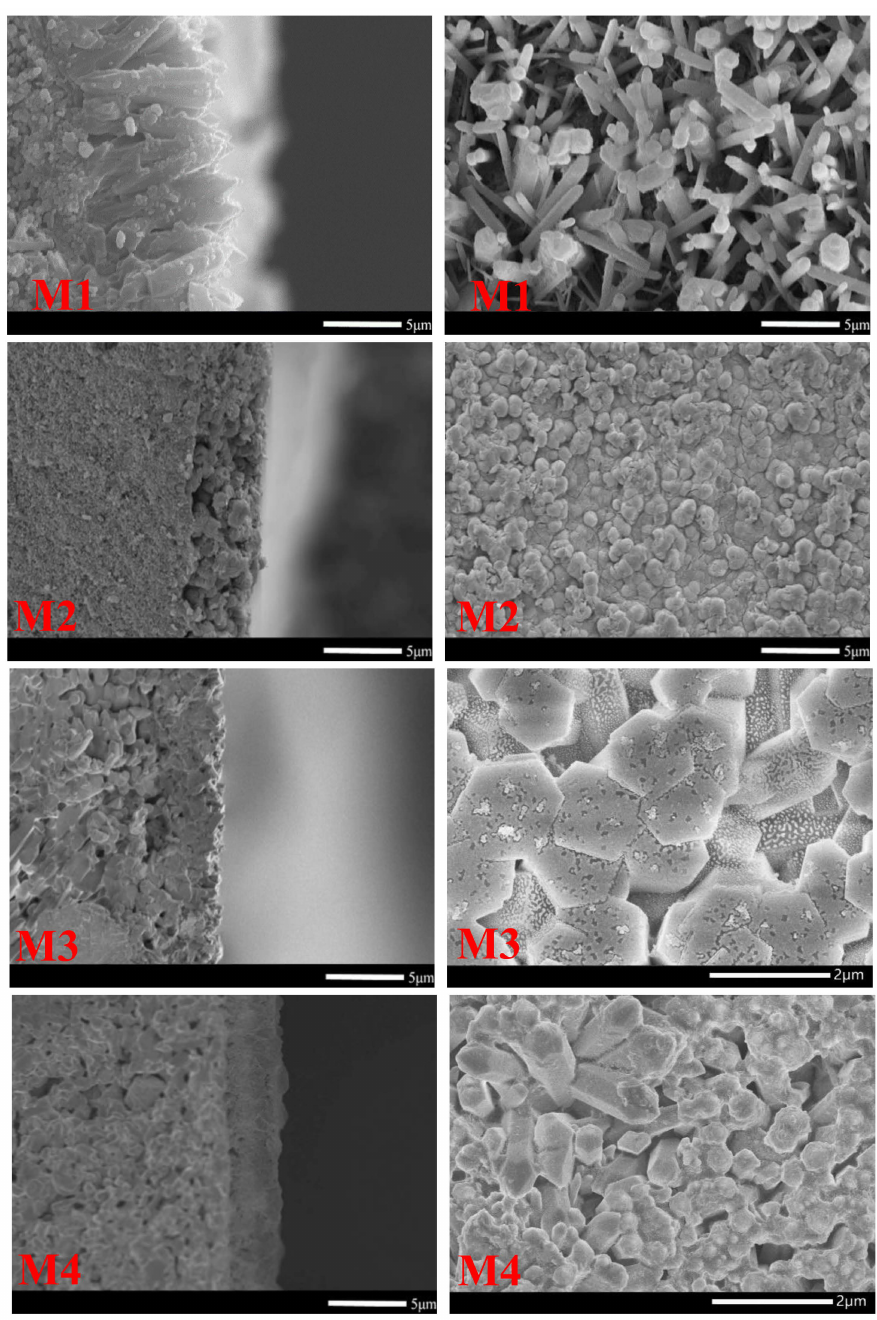
Figure 4. SEM top view ( right ) and cross-section ( left ) of AlPO 4 -5 membrane second growth on α -Al 2 O 3